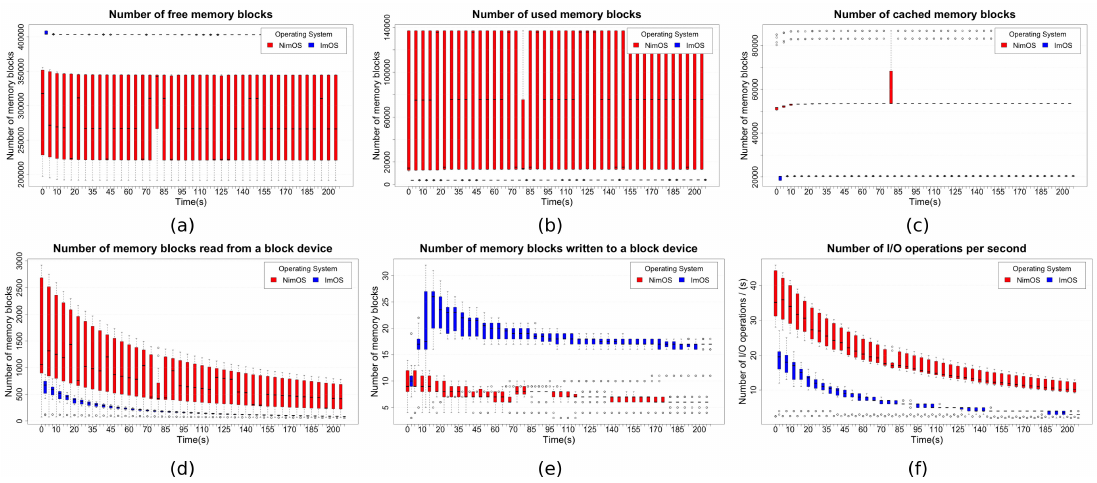
Figure 9. Wearable prototype I/O performance when running ImOS and NimOS: ( a ) number of free memory blocks. ( b ) Number of memory blocks in use. ( c ) Number of cached memory blocks. ( d ) Number of memory blocks read from a block device. ( e ) Number of memory blocks written to a block device. ( f ) Number of I/O operations per